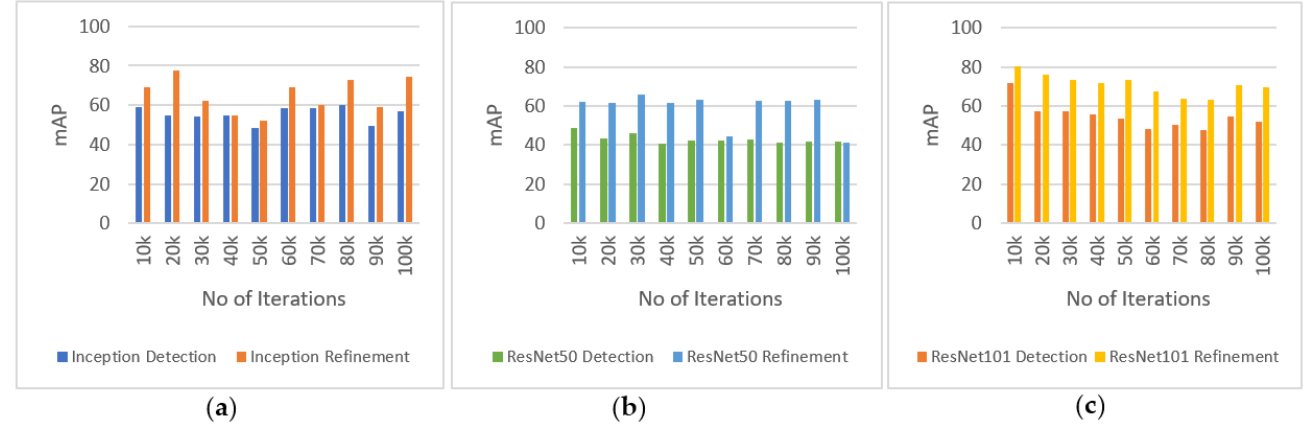
Figure 8. Experiment performed with image set 1 show mean average precision (mAP) of detection refinement with ( a ) detections with Inception model and refinements; ( b ) detections with ResNet50 model and refinements; ( c ) detections with ResNet101 model and refinements.